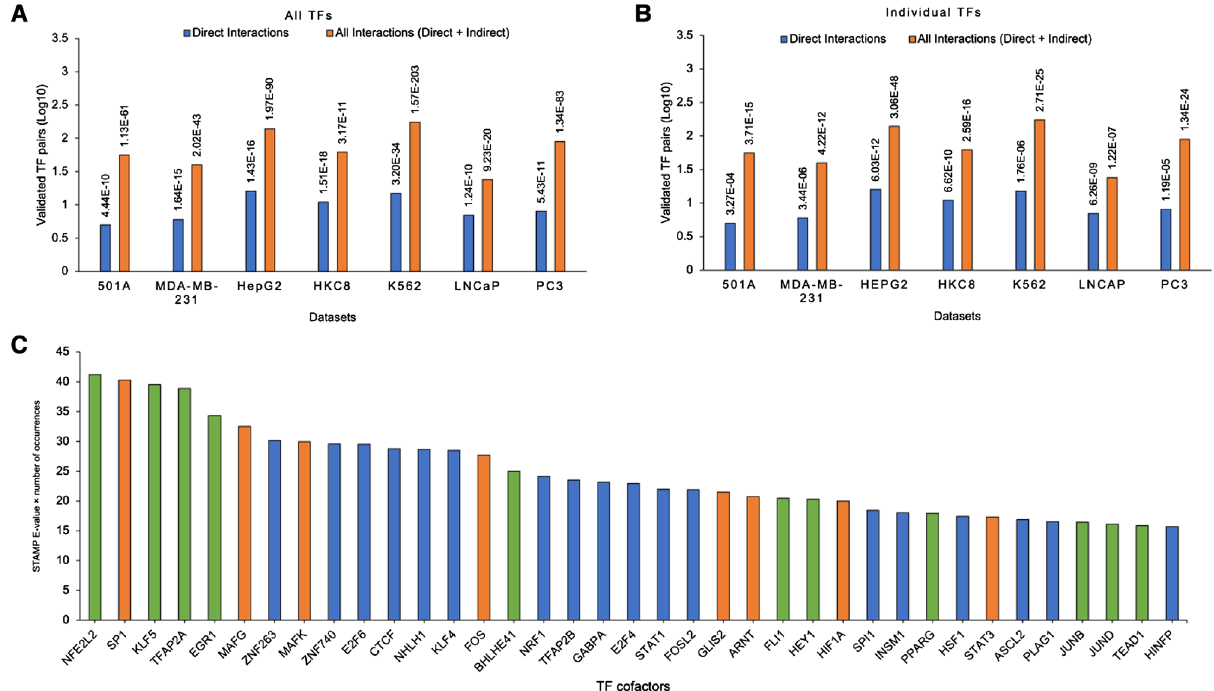
Figure 2. The predicted cofactors are biologically sound. ( A ) and ( B ) Overrepresentation of the known TF-TF interactions in the predicted cofactor pairs. One predicted motif may correspond to multiple TFs in ( A ) while only one TF in ( B ). ( C ) The top 37 HIF1A cofactors ranked by the multiple of the -log of the STAMP E-value of its predicted motif and the number of motif modules in which this predicted motif occurred. An orange bar indicates that these cofactors were in BIND, HPRD, or BioGRID. A green bar indicates that they were not in the above databases but supported by literature. A blue bar indicates the remaining novel